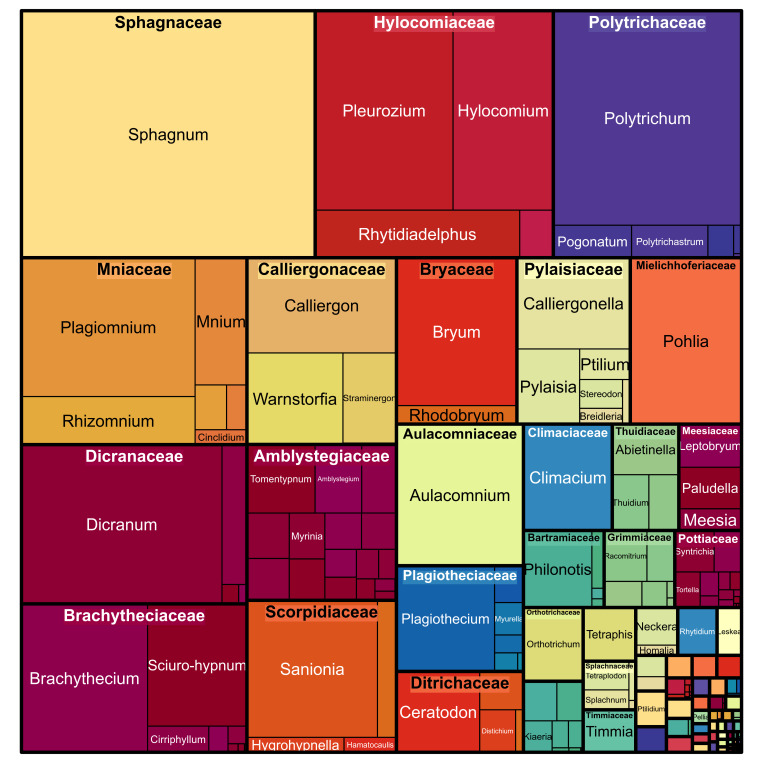
Taxonomic distribution of occurrences amongst moss families in the dataset. The figure was prepared with the “treemap” package in R (Tennekes 2017).